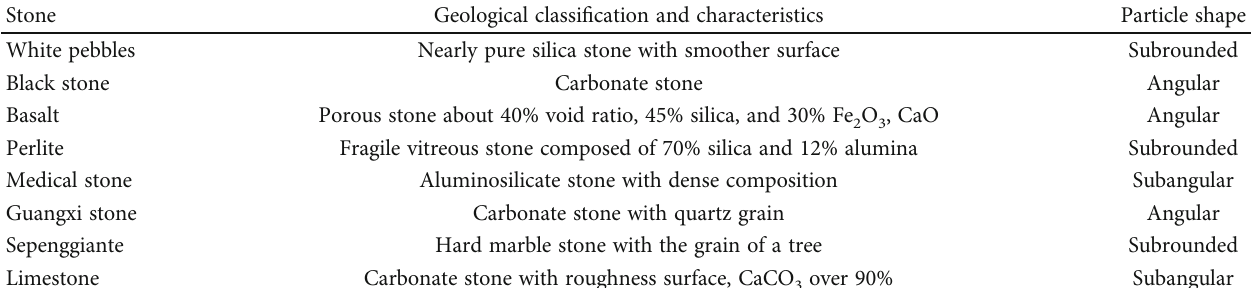
Table 1: Summary of the geological classi fi cation and characteristics and particle shape classi fi cation.